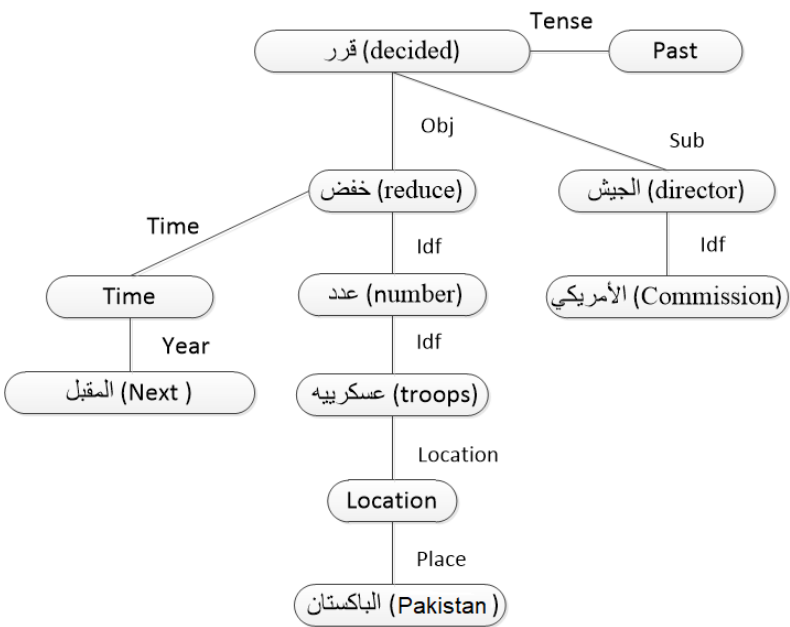
Figure A2. Semantic representation sample number 2.